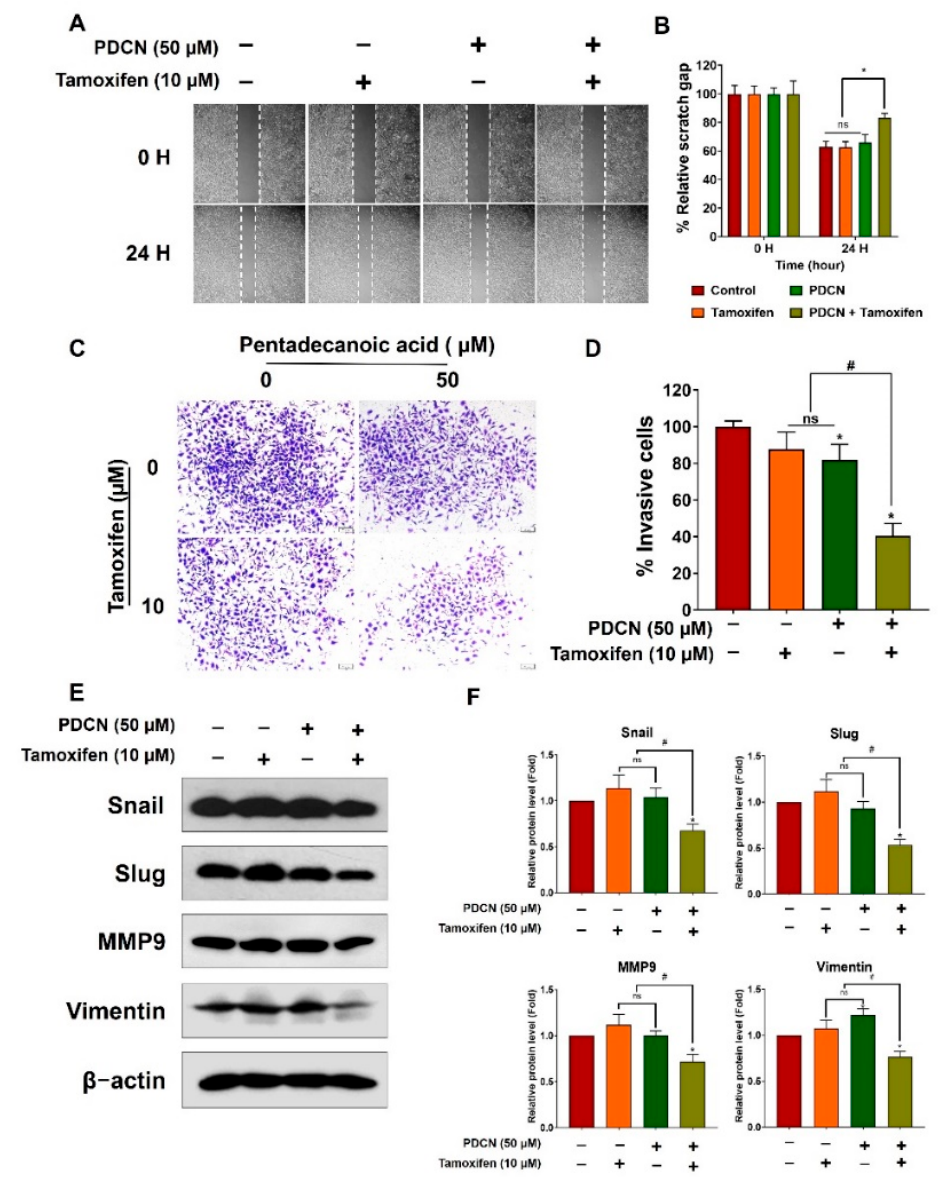
Figure 6. Combined treatment with pentadecanoic acid and tamoxifen suppressed EMT. ( A , B ) Cell migration determined using the wound healing assay following treatment for 48 h in MCF − 7/SC cells. ( C , D ) Invasive cells determined after pentadecanoic acid treatment alone or in com- bination with tamoxifen for 48 h. ( E , F ) Western blot analysis of epithelial–mesenchymal transition